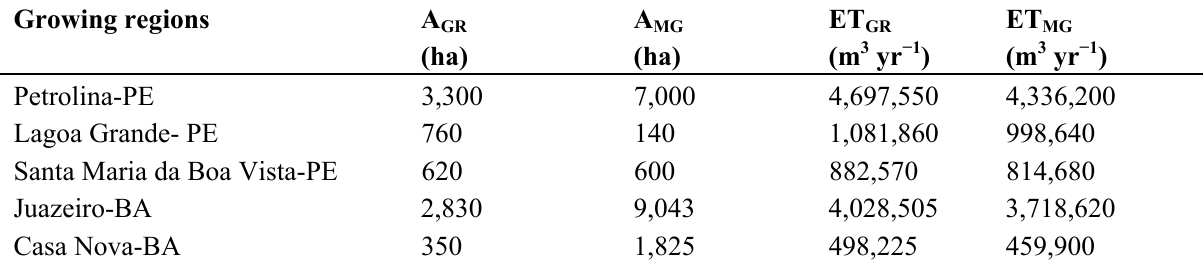
Table 7. Area of the main irrigated crops and annual actual evapotranspiration in the growing regions comprised of the net of agro-meteorological stations in